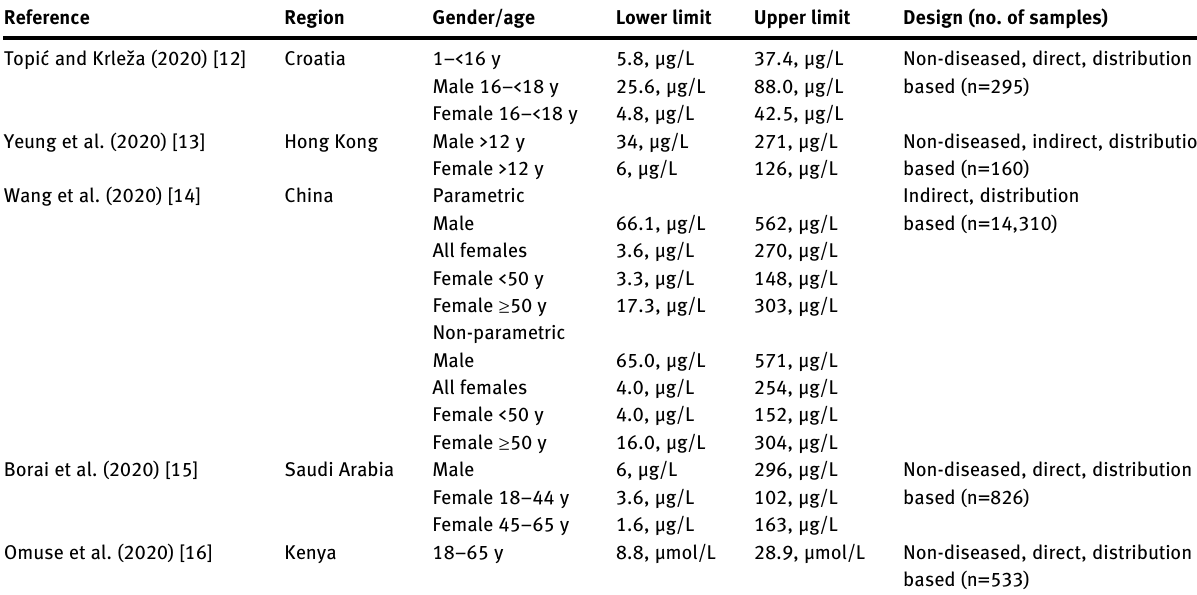
Table  : Select reference interval studies from  reporting serum ferritin results by direct and indirect approaches. Reference